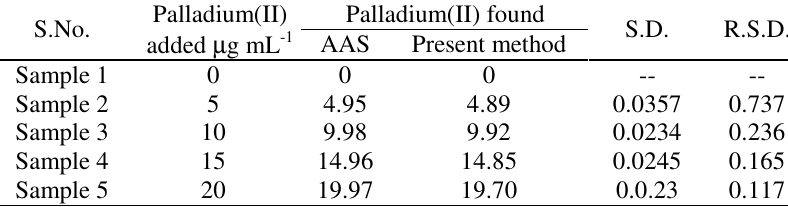
Tabl e 2. Determination of palladium(II) in water samples